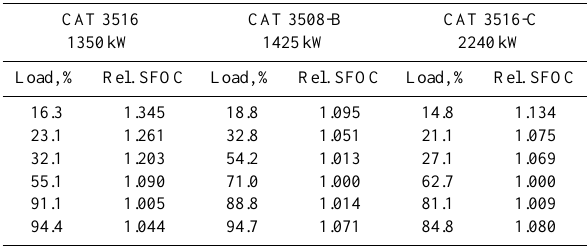
Table B1. Measured specific fuel-oil consumption values as a func- tion of engine load, as reported in W¨artsil¨a (2007) for four-stroke engines. This set of data includes the measurements of “46” engine family, the reported power of which ranges from 5850kW (engine code 6L46) to 18480kW (16V46).